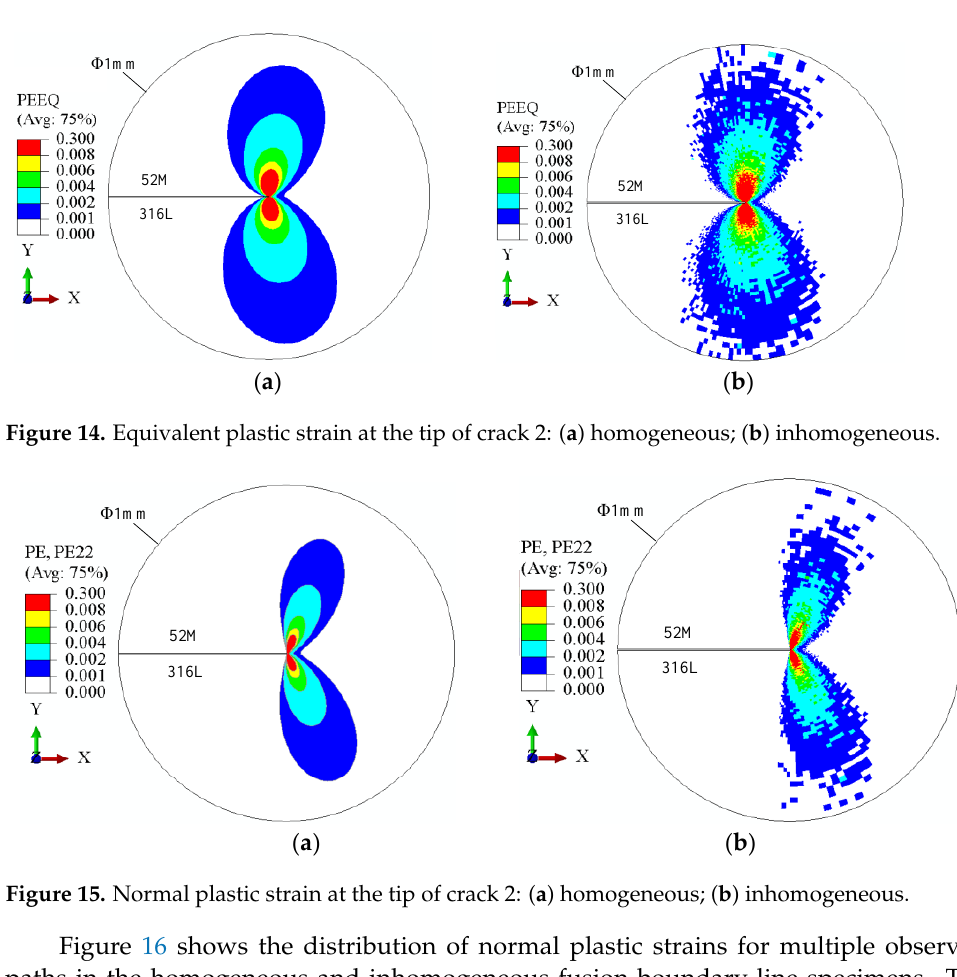
Figure 15. Normal plastic strain at the tip of crack 2: ( a ) homogeneous; ( b ) inhomogeneous.